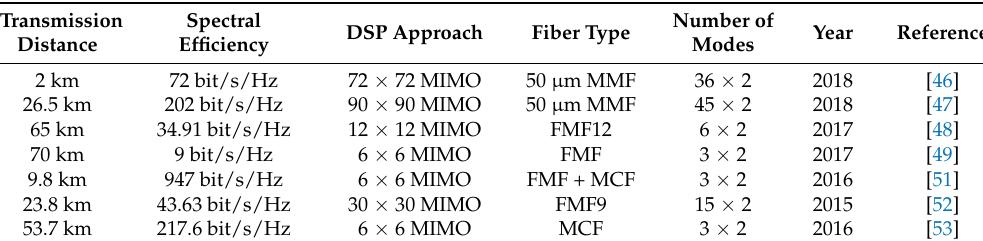
Table 2. Summary table of recent experimental validations using multi-input multi-output (MIMO) digital signal processing (DSP). MMF—multimode fiber; FMF—few-mode fiber; MCF—multicore fiber.